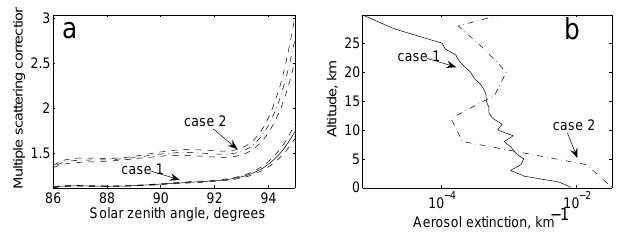
Fig. 5. (a) SZA dependencies of multiple scattering correction fac- tor (solid and dash-dotted line) for two cases of aerosol extinction profiles presented in panel (b) . Dashed lines represent Monte Carlo